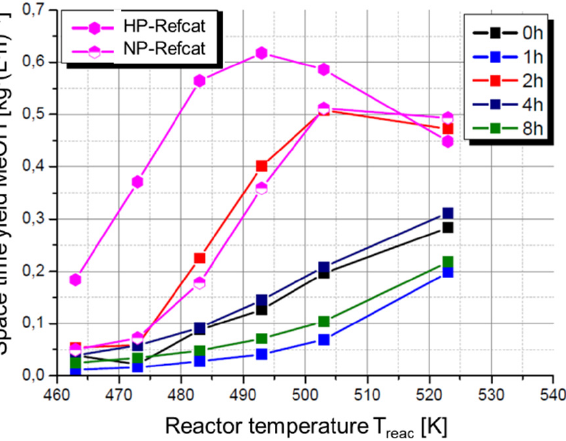
Figure 11. MeOH space time yield depending on the reactor temperature and the duration of the calcination. Catalyst system: Cu 0.61 Zn 0.21 Al 0.18 , h equ = 600, T calc = 873 K. Catalytic tests: p = 5 MPa, GHSV = 2400 h − 1 , S = 2, Feed = 22 vol% H 2 , 62 vol% CO, 6 vol% CO 2 , 10 vol% Ar.